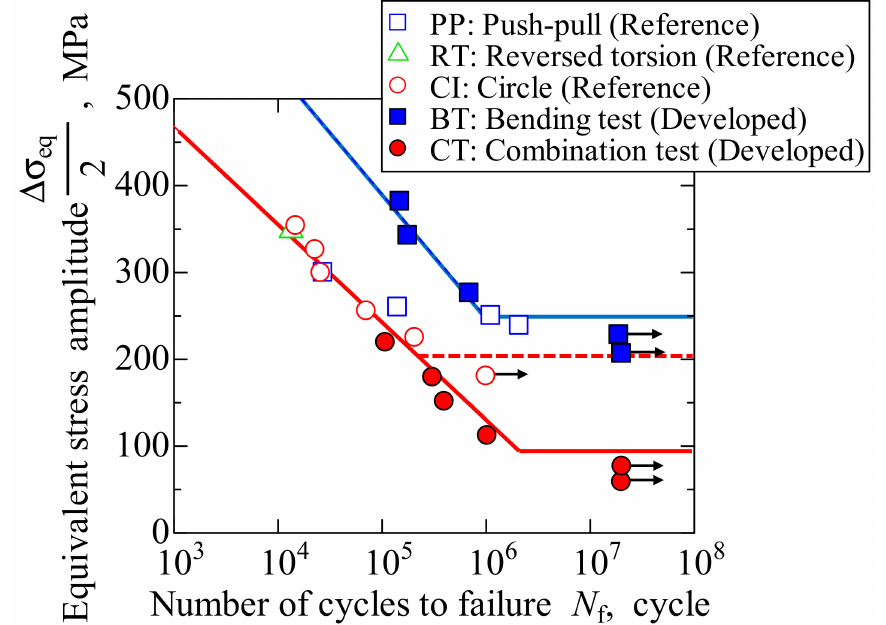
Figure 10. Fatigue test results for type 490A hot-rolled